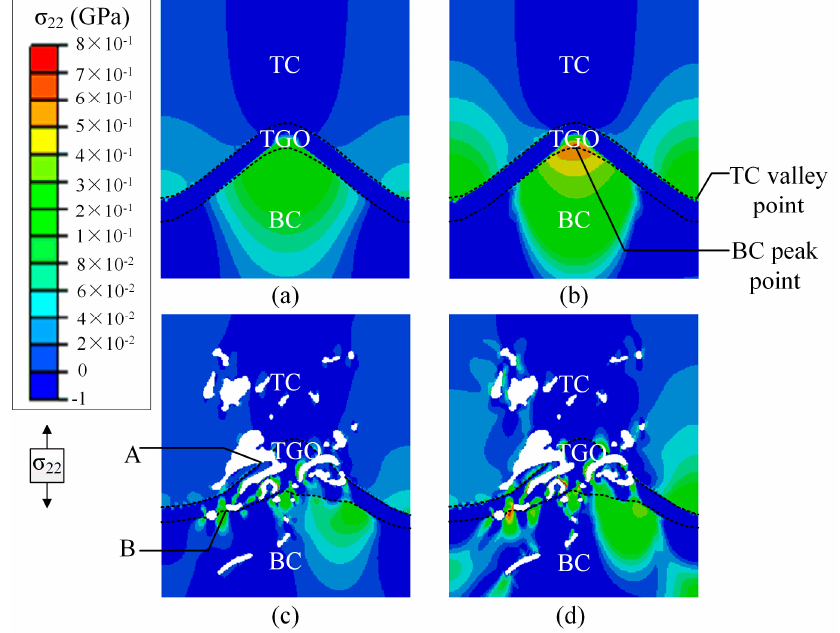
Figure 8. Contour plots of stress σ 22 , after 300 h oxidation ( a ) at 1373 K and ( b ) 293 K in the sample of TBC with ideal interface and ( c ) at 1373 K and ( d ) 293 K in the sample of TBC with actual microstructures.